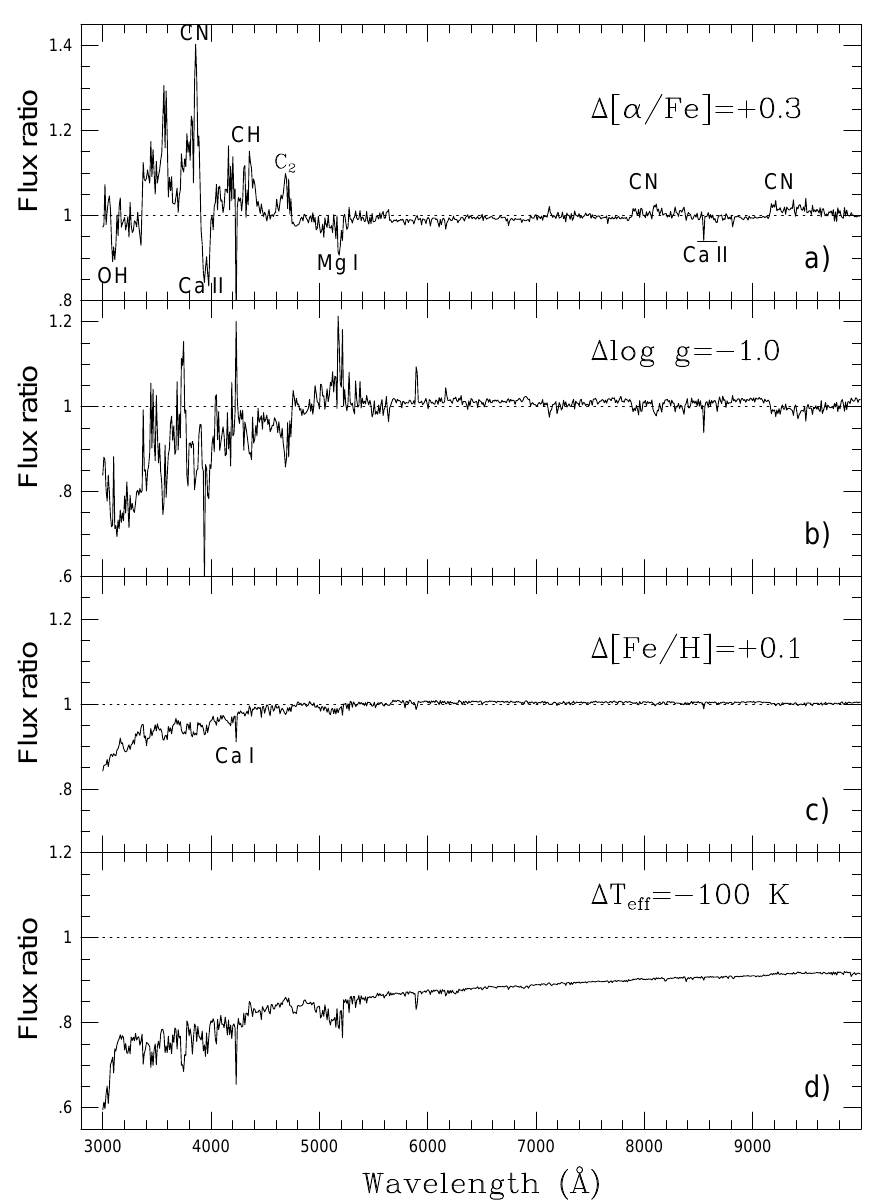
Fig. 2. Sensitivity of the modeled surface energy flux ratios to varia- tions in fundamental stellar atmospheric parameters and chemical abun- dances (Tautvaiˇsien˙e & Edvardsson 2002). The standard model has T e = 4500 K, log g = 3.0, [Fe/H] = –0.4 and [ α /Fe] = 0.0. In the top panel, oxygen is included among the α